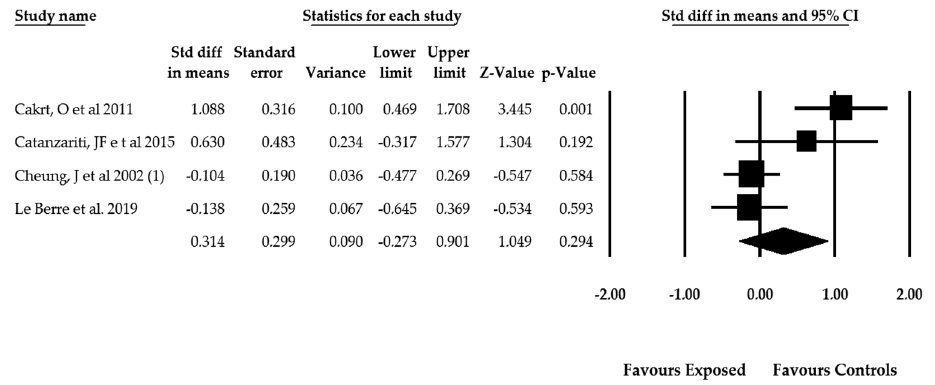
Figure 4. Forest plot for the perception of the visual verticality assessed with the SVV in patients with idiopathic scoliosis (effect sizes are expressed as standardized mean difference).